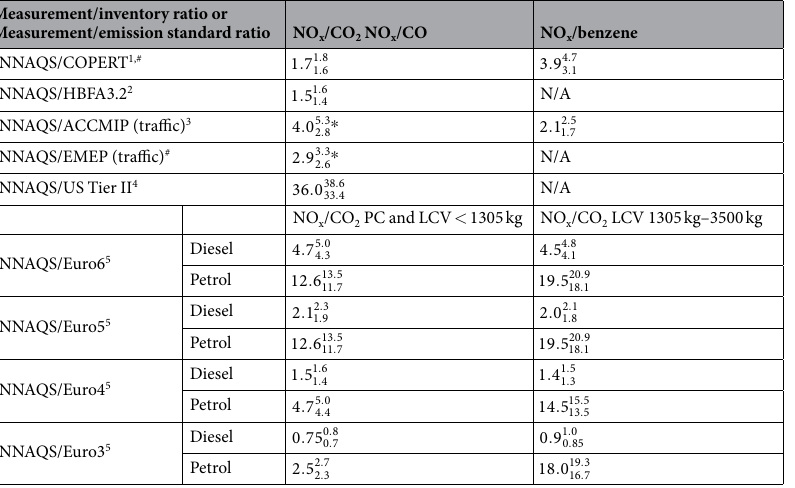
Table 1. Measurement – inventory comparison (i.e. measured/modelled flux (emission) ratio). The uncertainty range is given by sub- and superscripts. PC: passenger cars; LCV: light commercial vehicle. 1 COPERT emission model ( SI ). 2 HBFA 3.2 ( SI ). Comparison with HBFA 3.3, that was published during the copy editing phase, yielded an average bias of 1.2. 3 ACCMIP – ( SI ). 4 US EPA 22 . 5 EEA 24 . * For inventories that do not explicitly report CO 2 , we converted data using the measured midday range of CO to CO 2 flux ratios (3.6 to 4.6 ppbv/ ppmv), which fall close to a recent evaluation based on a road tunnel study 45 . # Data are trend adjusted for 2015 according to GAINS (http://gains.iiasa.ac.at/models/) 23